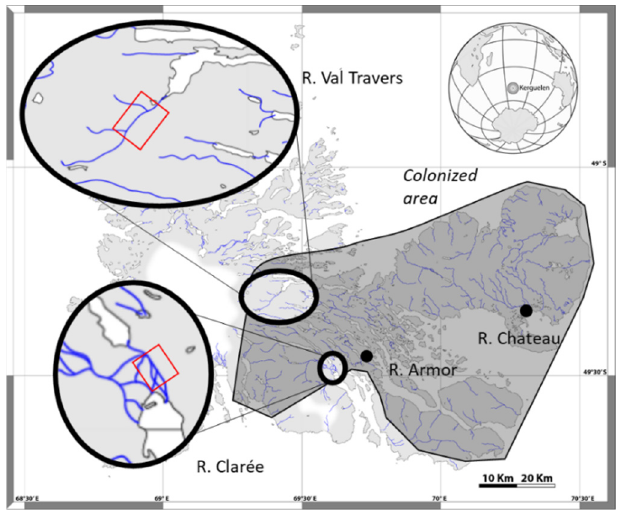
Figure 1. Location of the two studied systems in the Kerguelen islands. In each system, the red rectangle indicates the area where sampling took place. The grey polygon indicates the extent of the colonized area by brown trout in 2018.